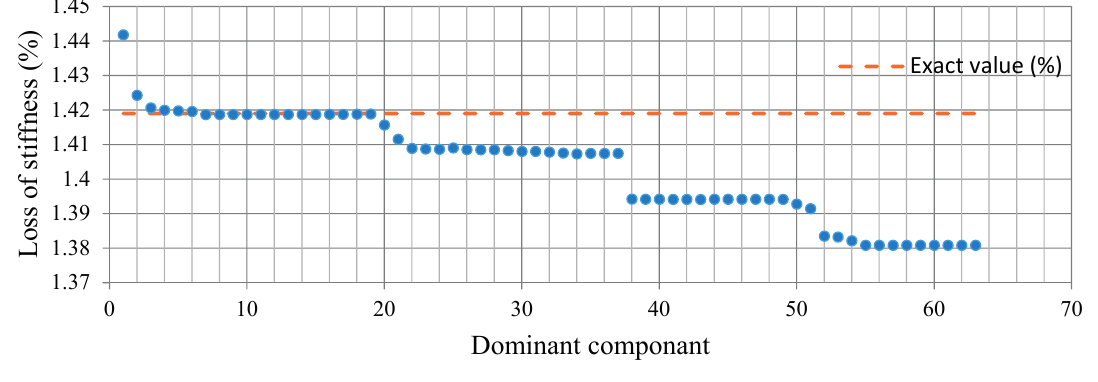
Figure 10. The relative energy distribution of acceleration response for Case 2.